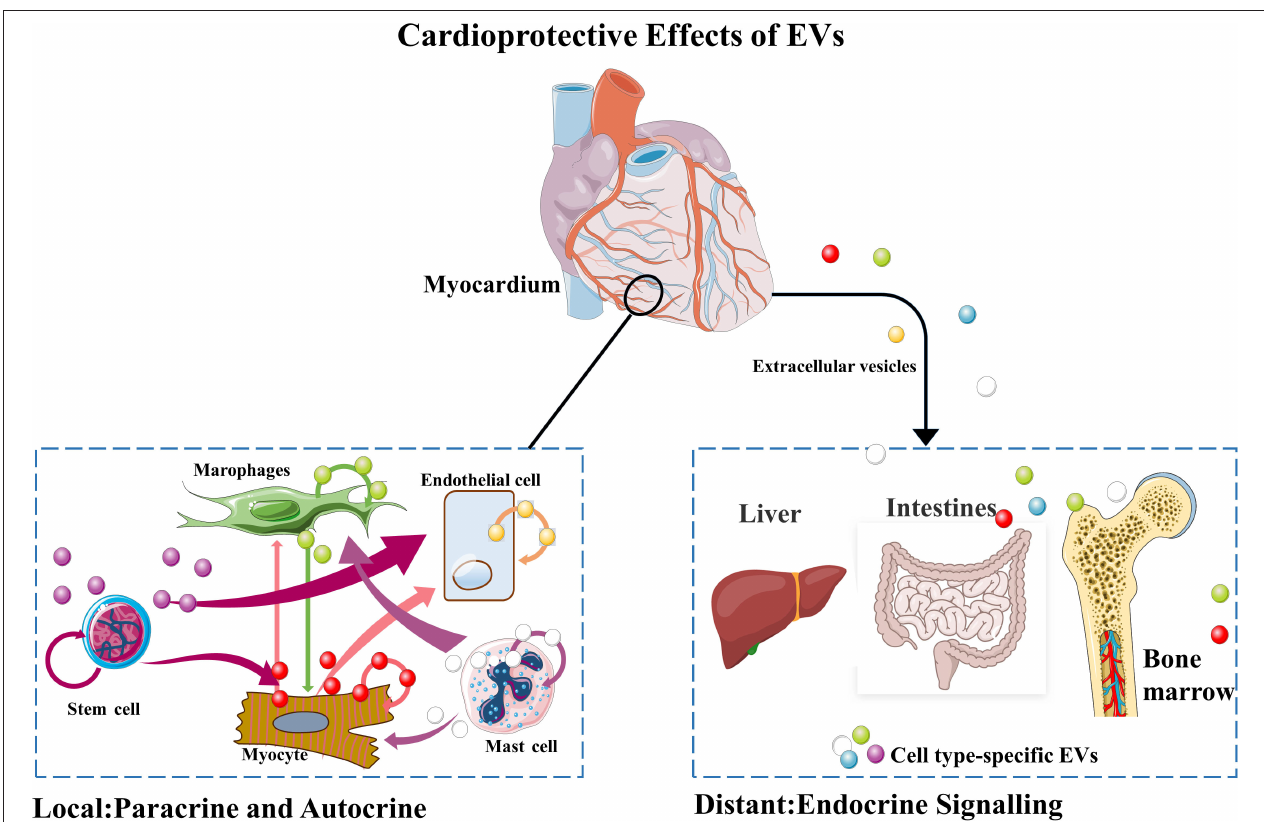
FIGURE 1 | Mechanisms of EVs-mediated local and distal communications of the